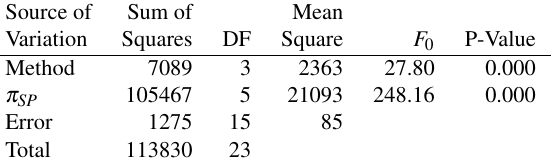
Table 14. ANOVA for DAP-TC ( π SP is